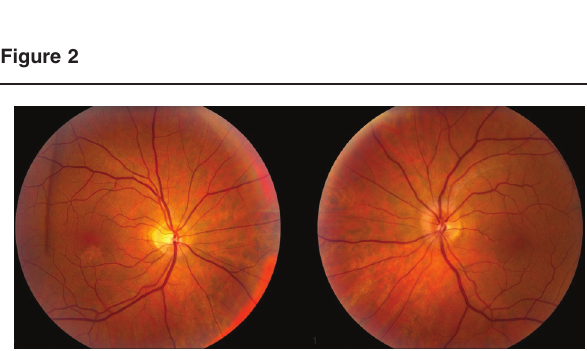
Optical coherence tomography (OCT) revealed leakage at the mac- ula and optic nerve head.